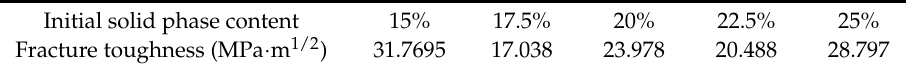
Table 2. Fracture toughness of layered Al 2 O 3 /PMMA composites with different initial solid phase content.